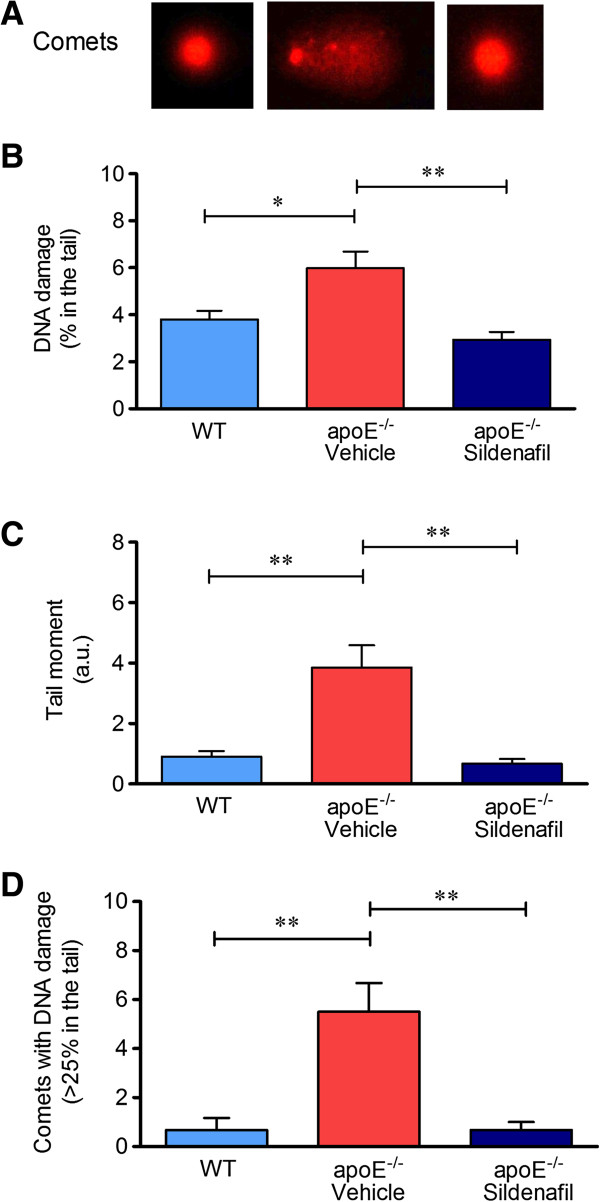
Detection of DNA damage in MNC assessed by alkaline comet assay. (A) Typical comets showing higher DNA fragmentation in apoE-/- vehicle compared to control WT, which contrasts with apoE-/- sildenafil; (B) Bar graph showing the mean of percentage of DNA in tail; (C) Bar graph showing the mean of tail moment (in a.u.); (D) Bar graph showing the mean of the number of comets with moderate-to-high damage (more than 25% of DNA in the tail). The values are presented as means ± SEM; 6 to 8 animals per group. *p < 0.05 and **p < 0.01, ANOVA).